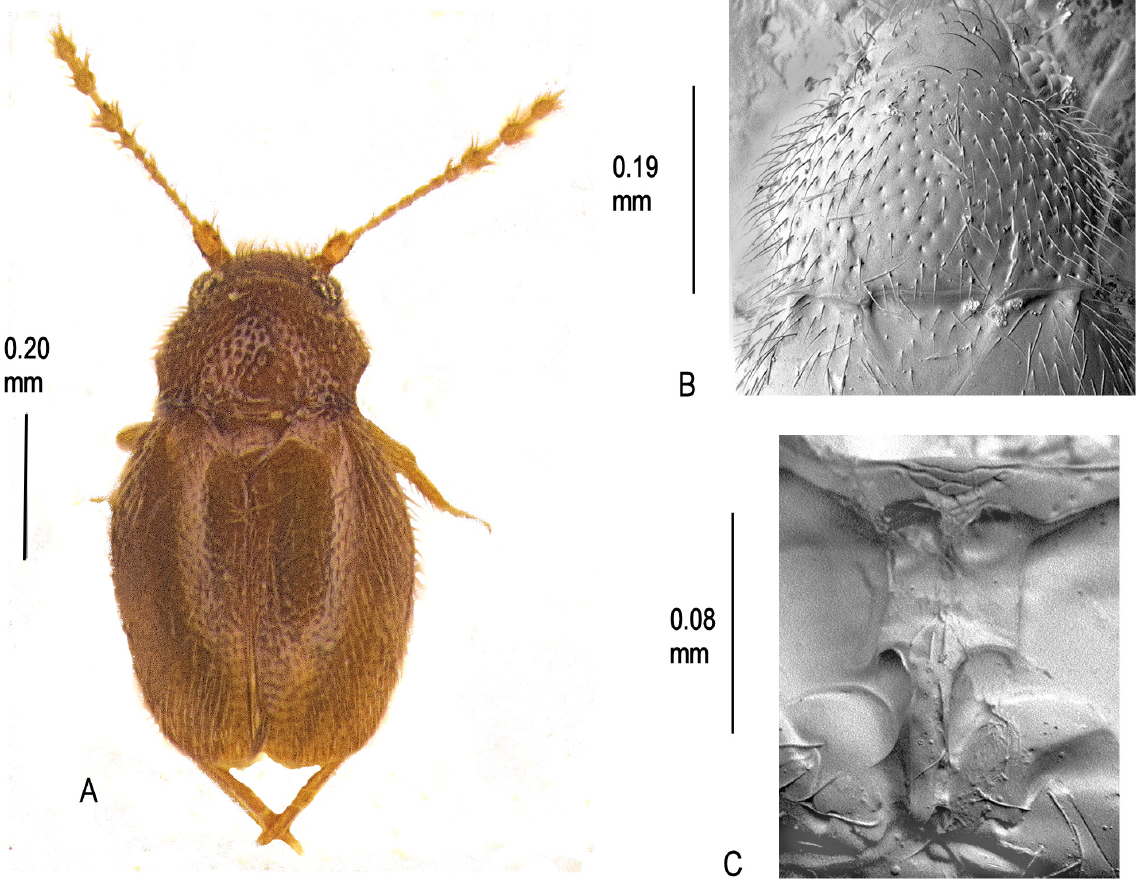
Fig. 57 . Cissidium murphyi sp. nov. A . Habitus. B . Pronotum, × 555. C . Mesoventrite showing median process of collar, mid-keel and keel, ×